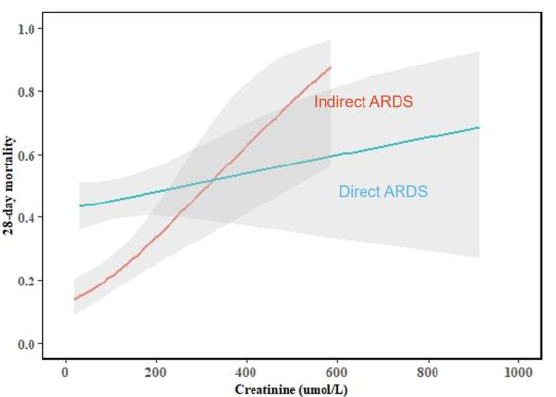
Figure 2. The interaction between creatinine and ARDS type (test for interaction, p = 0.001).